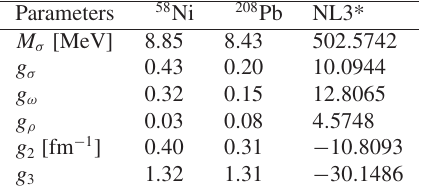
Table 1. The RMSE values of the ANN test results and the values of the NL3* parameters.